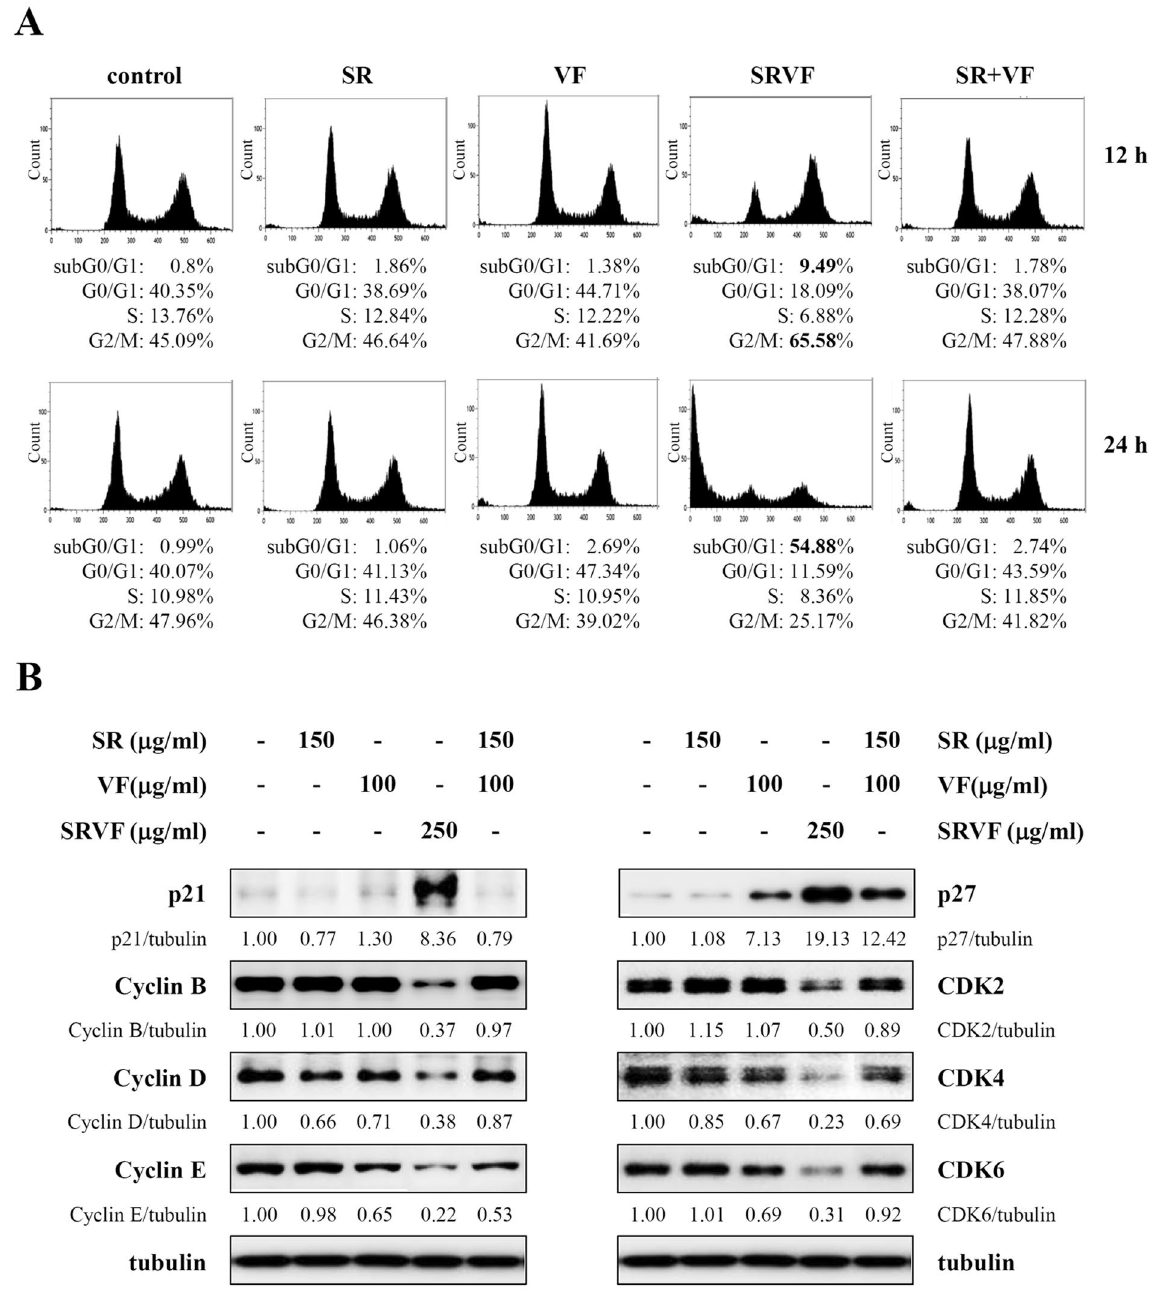
Figure 2. SRVF induces cell cycle arrest at G 2 /M phase in HT1080 cells. ( A ) Cells were incubated with SR, VF, or SRVF at a concentration of 250 µ g/ml for 12 or 24 h, and cell cycle distribution was examined by flow cytometry after staining intracellular DNA with propidium iodide solution. Cell cycle distribution was analyzed using Kaluza software and is expressed as the relative percentage. Data are representative of three independent experiments. ( B ) The expression of cell cycle-related proteins was examined by Western blot analysis in cells treated with SR, VF, or SRVF at a concentration of 250 µ g/ml for 12 h. Relative band intensities were calculated using ImageJ software after normalizing to tubulin expression. The full size blot is shown in Supplementary Fig.